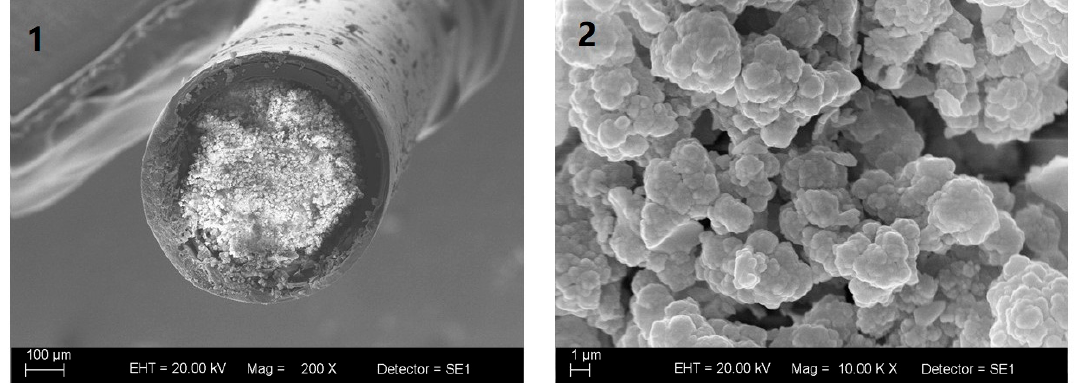
Figure 3. Scanning electron microscope images of the cross-section of poly(butyl methacrylate-co-ethyleneglicol dimethacrylate) monolith capillary at ( 1 ) 200× magnification and ( 2 ) 10,000× magnification.